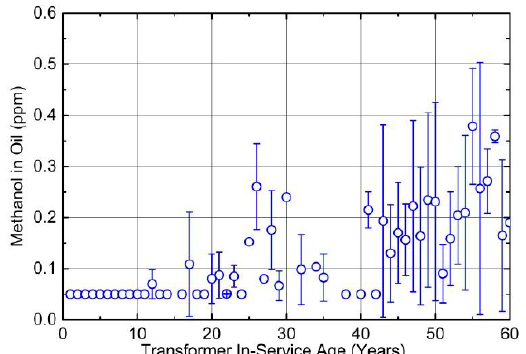
Figure 13. Variation in methanol for in-service aged transformer oil samples [82].